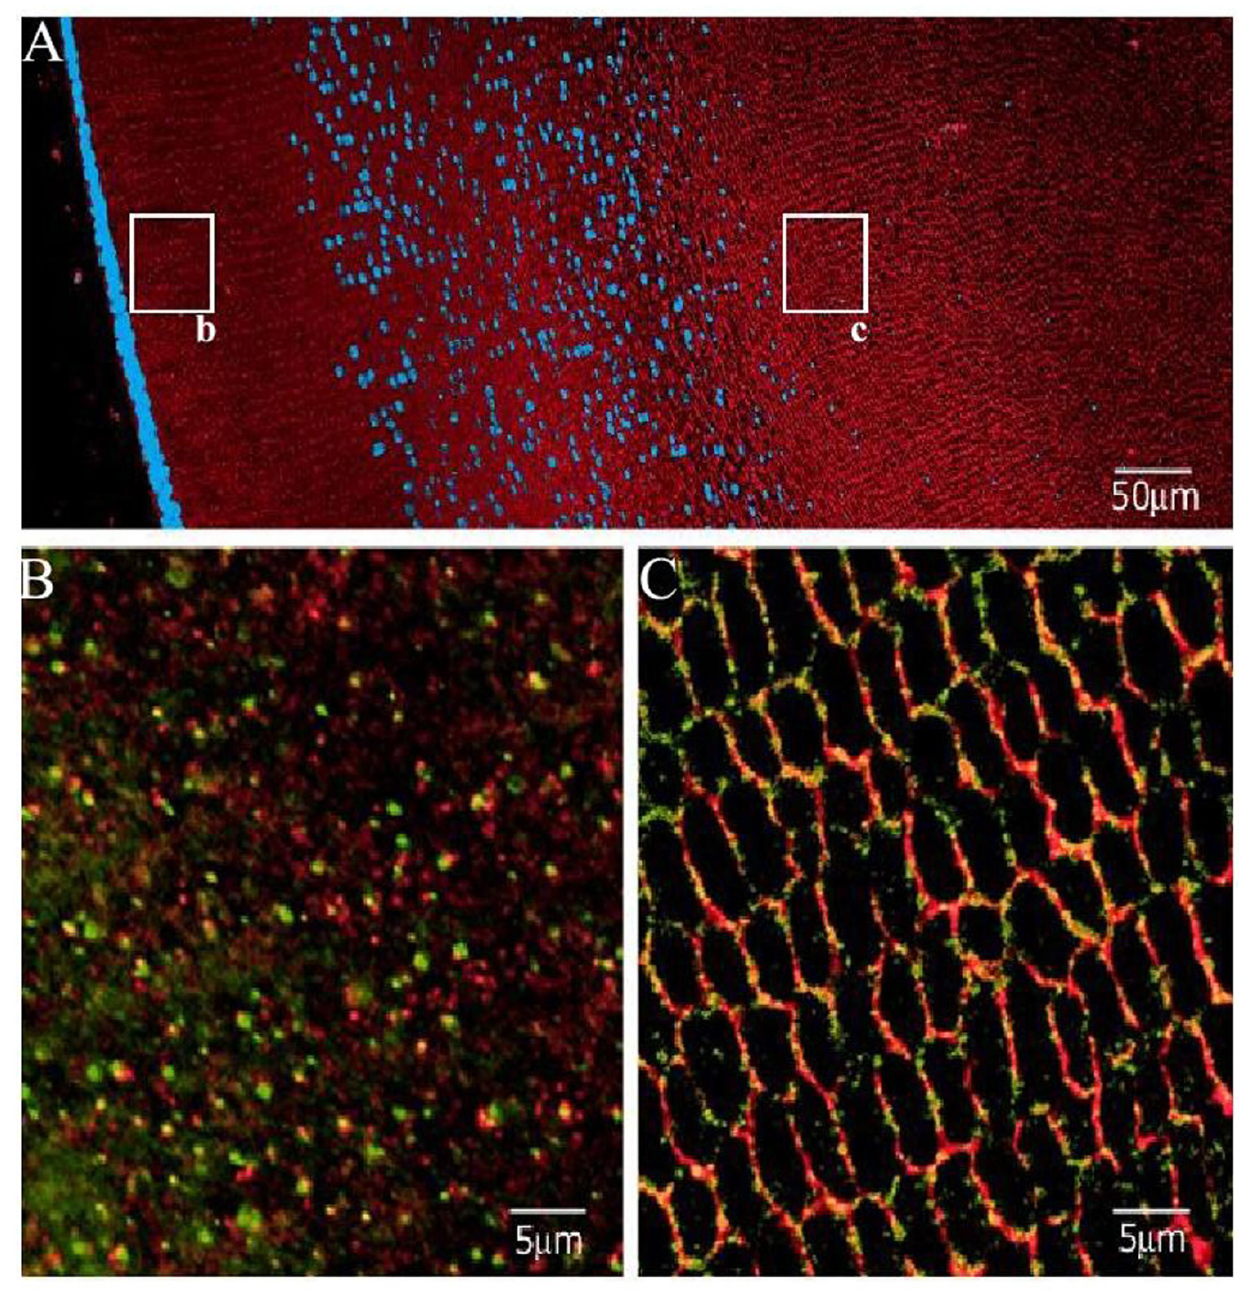
Figure 1 Spatial distribution of MP20 and galectin-3 in the lens. (A) Overview of the distribution of MP20 (red) in relation to cell nuclei (blue) as a marker for fiber cell differentiation in equatorial sections. (B) Co-localisation of MP20 (red) and galectin-3 (green) in peripheral cortex as indicated by box b in panel A. (C) Co-localisation of MP20 and galectin-3 in an area approxi- mately 500 m into the cortex as indicated by box c in panel A. Yellow indicates regions of overlap of both